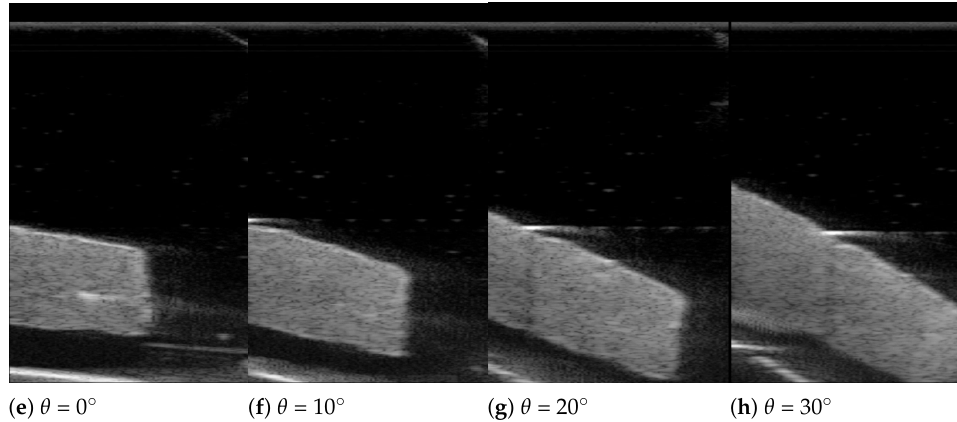
Figure 13. Images during ultrasound